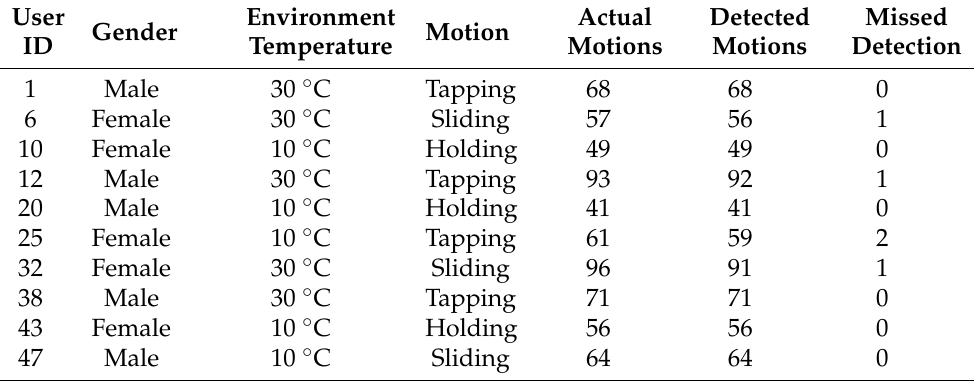
Table 3. Motion Detect Rate (We select 10 users from 50 users as